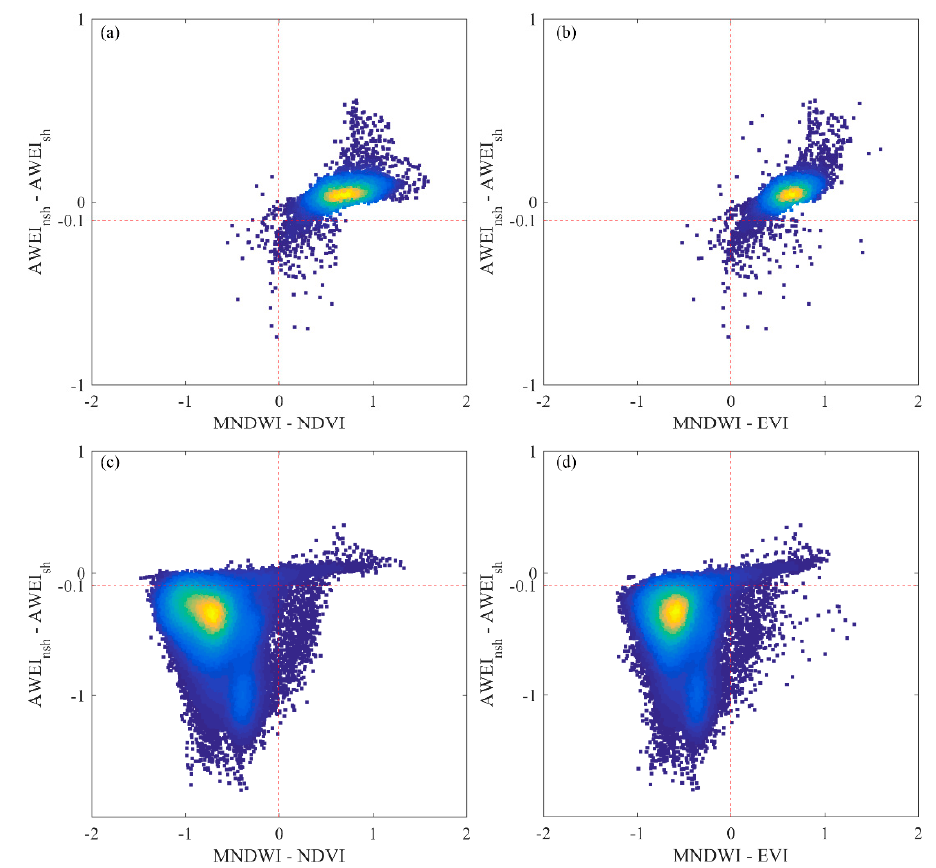
Figure 3. The spatial distribution of sampling plots and 10%, 50%, and 90% percentile composite images for three sampling plots. The number in sampling plots indicates the Landsat path (the first three digits) and row (The last three digits).